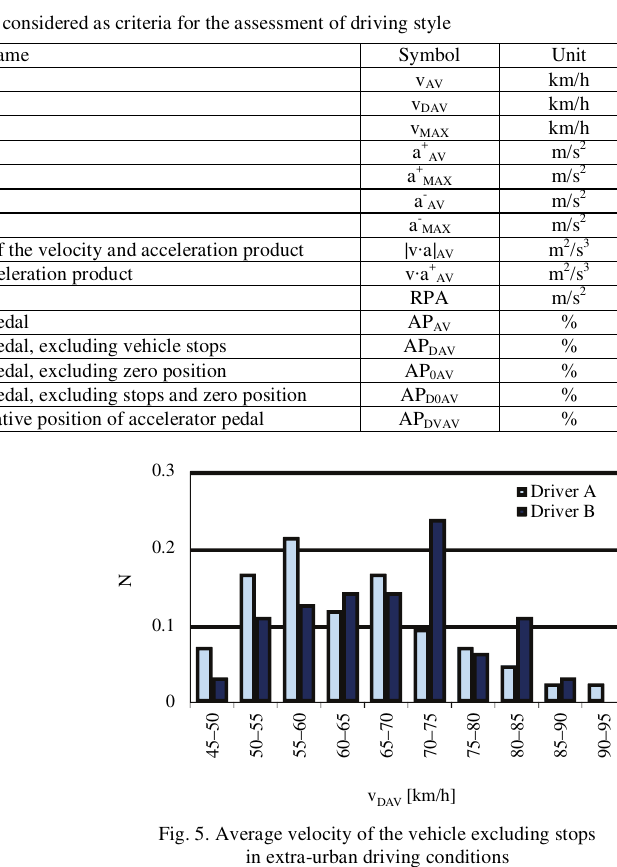
Fig. 5. Average velocity of the vehicle excluding stops in extra-urban driving conditions